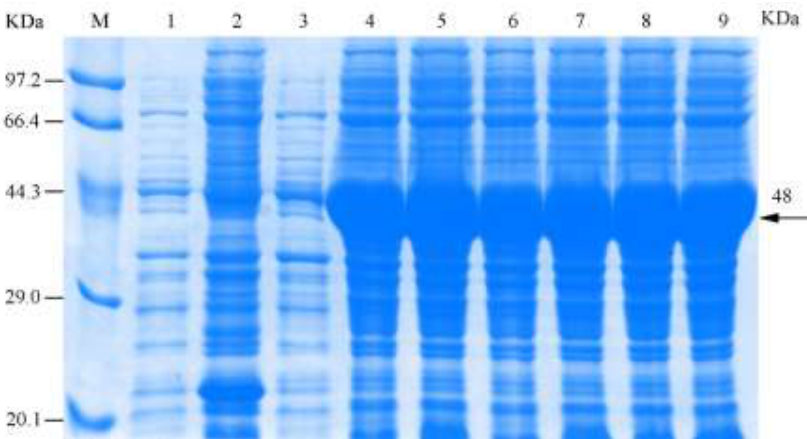
Figure 6. SDS (sodium dodecyl sulfate)-PAGE (polyacrylamide gel) analysis of pET32a(+)- ChiKJ406136 expression induced by IPTG (isopropyl-b-D-thio-galactoside) M: Protein marker (low molecular weight standard);1: pET-32a (+) without induction; 2: pET-32a (+) induced by IPTG (1.0 mmol/L); 3-9: pET32a(+)- ChiKJ406136 induced by IPTG, at concentrations of IPTG was 0, 0.2, 0.4, 0.6, 0.8, 1.0, and 1.2 mmol/L.